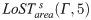
5-minute area coverage by district.(a) Area coverage. (b) Area LoST, LoSTarea s(Γ,5).